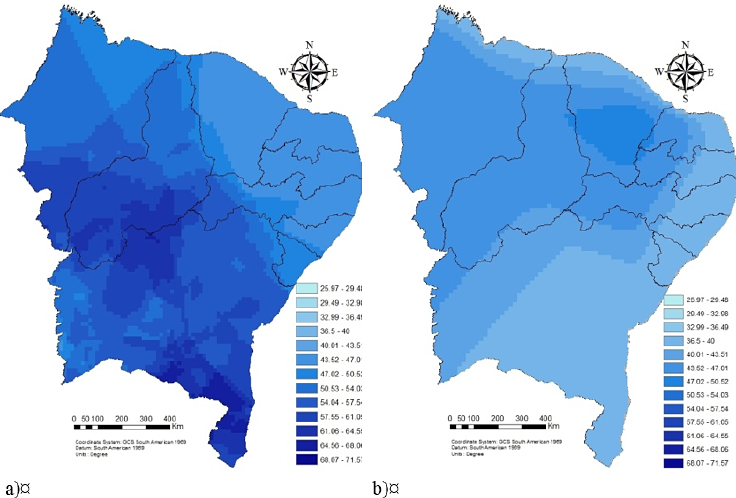
Figure 2. (a) r1h24h values in percentage determined in this study. (b) r1h24h based on the results of Torrico (1974) and Pfafstetter